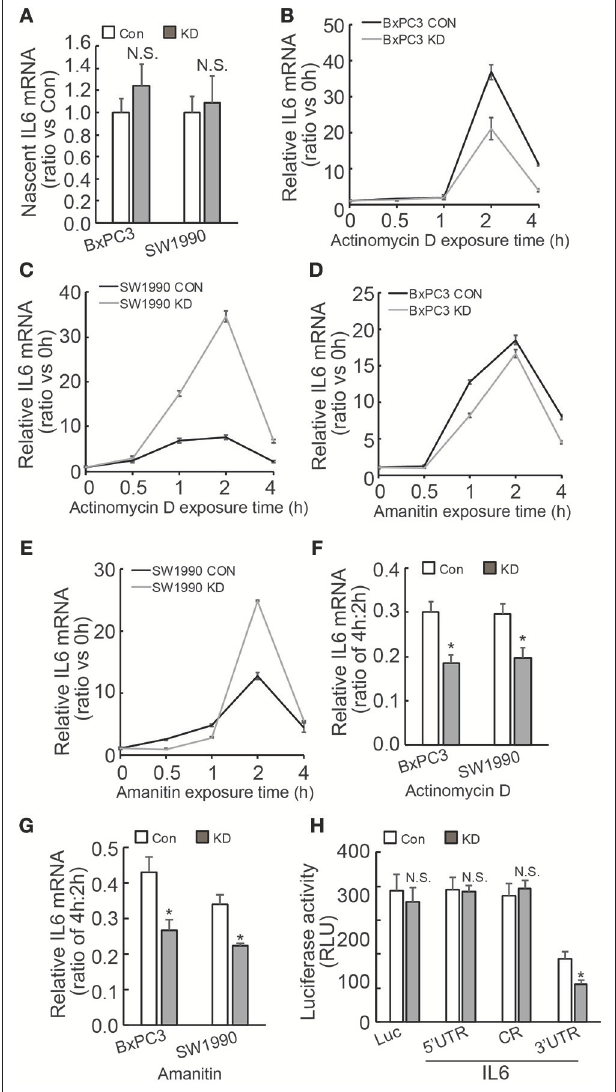
FIGURE 4 | BAG3 knockdown destabilizes IL6 mRNA via its 3 ′ UTR. (A) Nascent RNA was labeled and isolated, newly synthesized IL6 mRNA was analyzed using real-time RT-PCR in control or BAG3 knockdown PDAC cells. (B,C) Actinomycin D was added for the indicated period to block RNA synthesis, and IL6 mRNA was analyzed using real-time RT-PCR in control or BAG3 knockdown BxPC3 (B) or SW1990 (C) cells. (D,E) Amanitin was added for the indicated period to block RNA synthesis, and IL6 mRNA was analyzed using real-time RT-PCR in control or BAG3 knockdown BxPC3 (D) or SW1990 (E) cells. (F,G) Relative IL6 mRNA expression at 4 h of Actinomycin D (F) or Amanitin (G) was normalized by that of 2 h. (H) Control or BAG3 knockdown BxPC3 cells were transfected with the indicated luciferase reporter vector and a Renilla reporter vector. Luciferase activity was measured 2 days after transfection and Renilla activity was measured to normalize luciferase activity. N.S., not significant; * P <